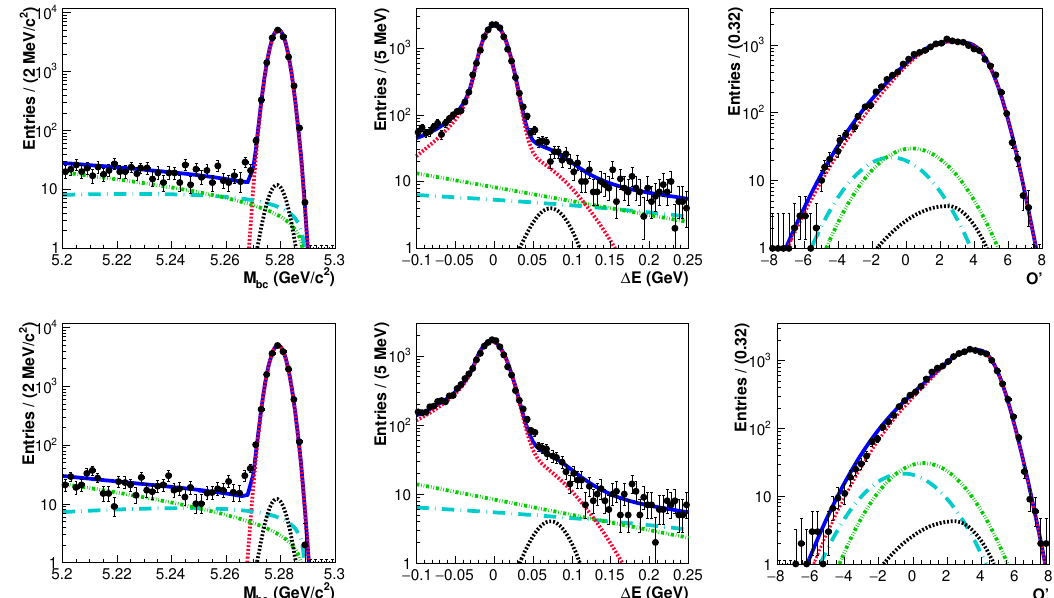
Figure 6 . M (left), ∆ E (middle), and O 0 (right) projections of three-dimensional unbinned bc extended maximum-likelihood fits to the data events that pass the selection criteria for B + → J/ψ ( → µ + µ − ) K + (top), and B + → J/ψ ( → e + e − ) K + (bottom). The legends are the same as in figure 1 and black dashed curve is [ π + J/ψ ] background.